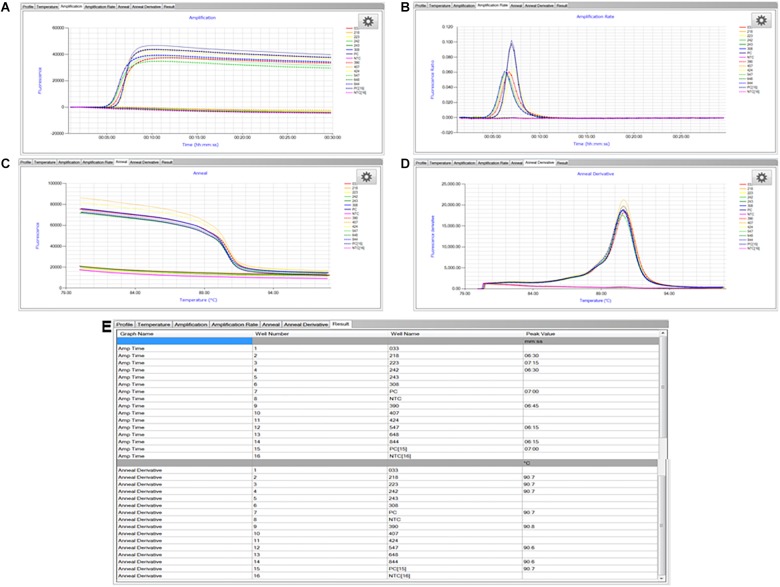
Representative LAMP graphs and results generated and viewed using the Genie Explorer software (version 2.0.6.3). (A) Amplification; (B) amplification rate; (C) anneal; (D) anneal derivative; and (E) results. Samples with three-digit codes correspond to dry dog food test portions with low-level inoculation of Salmonella Infantis ATCC 51741. Samples marked as PC are positive control, i.e., S. enterica Typhimurium ATCC 19585 (LT2) at 1.7 × 104 CFU/reaction. Samples marked as NTC are no template control, i.e., molecular grade water.